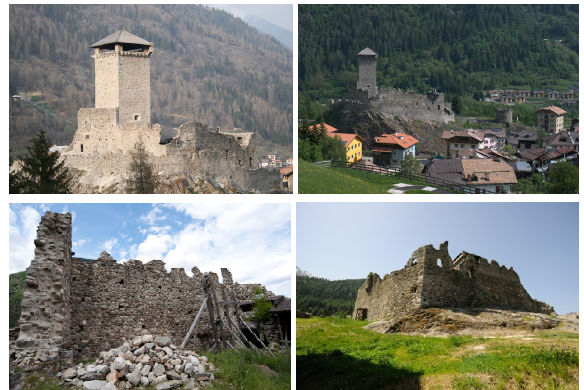
Figure 2: The Ossana castle with its complex and partly demolished